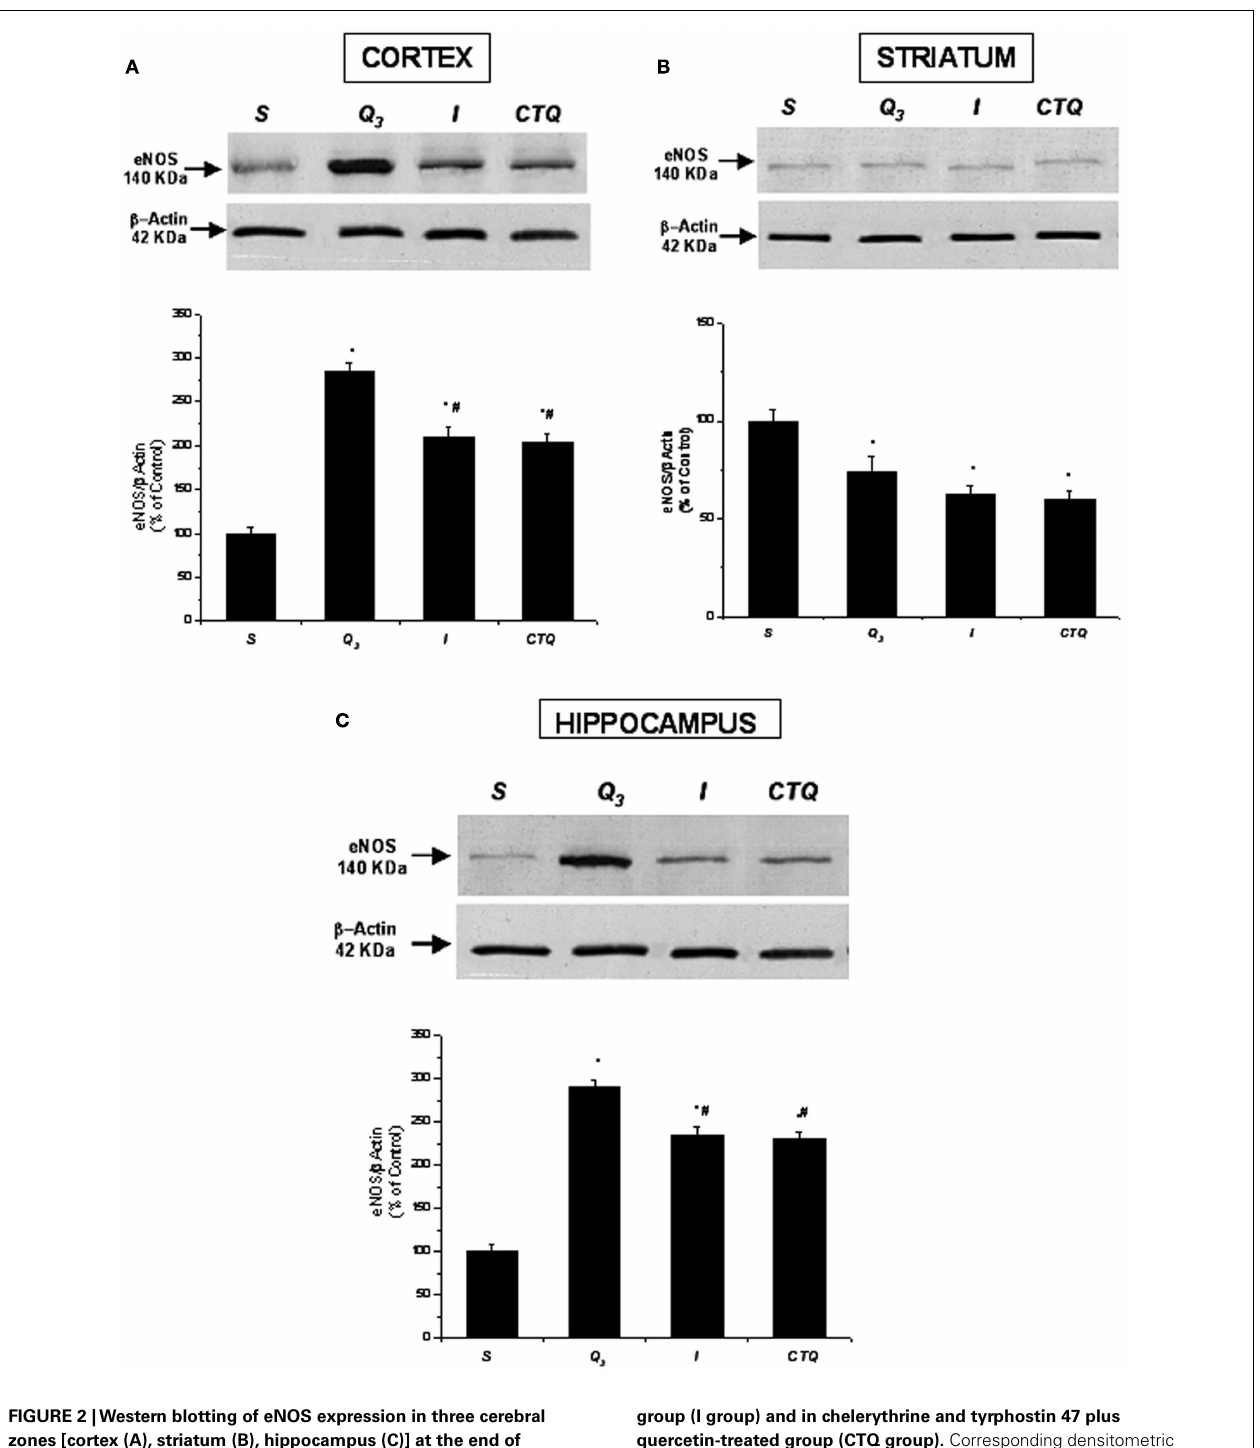
group (I group) and in chelerythrine and tyrphostin 47 plus quercetin-treated group (CTQ group). Corresponding densitometric values (mean ± SD) are reported on the bottom. ˚ p < 0.01 vs. S group, # p < 0.01 vs. Q 3 group.